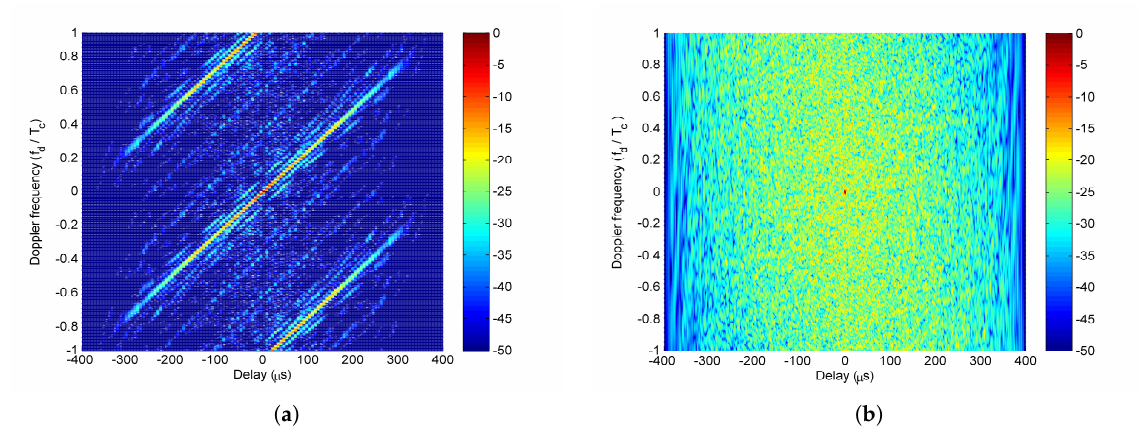
Figure 19. For the two-main-lobe, the ambiguity functions of ( a ) the approximate LFM waveforms by SIA, ξ = 0.5; ( b ) the optimized LFM-PC waveforms.